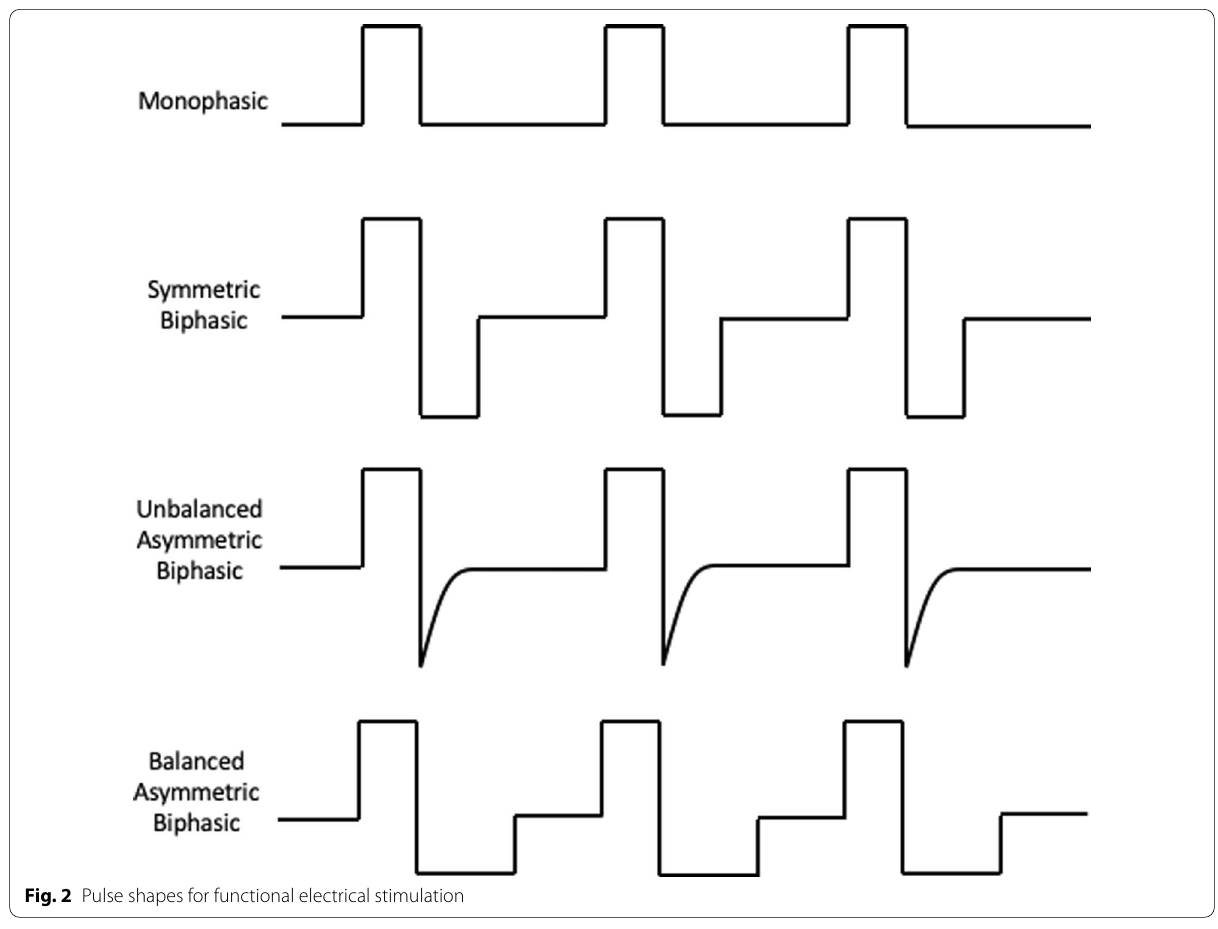
Fig. 2 Pulse shapes for functional electrical stimulation